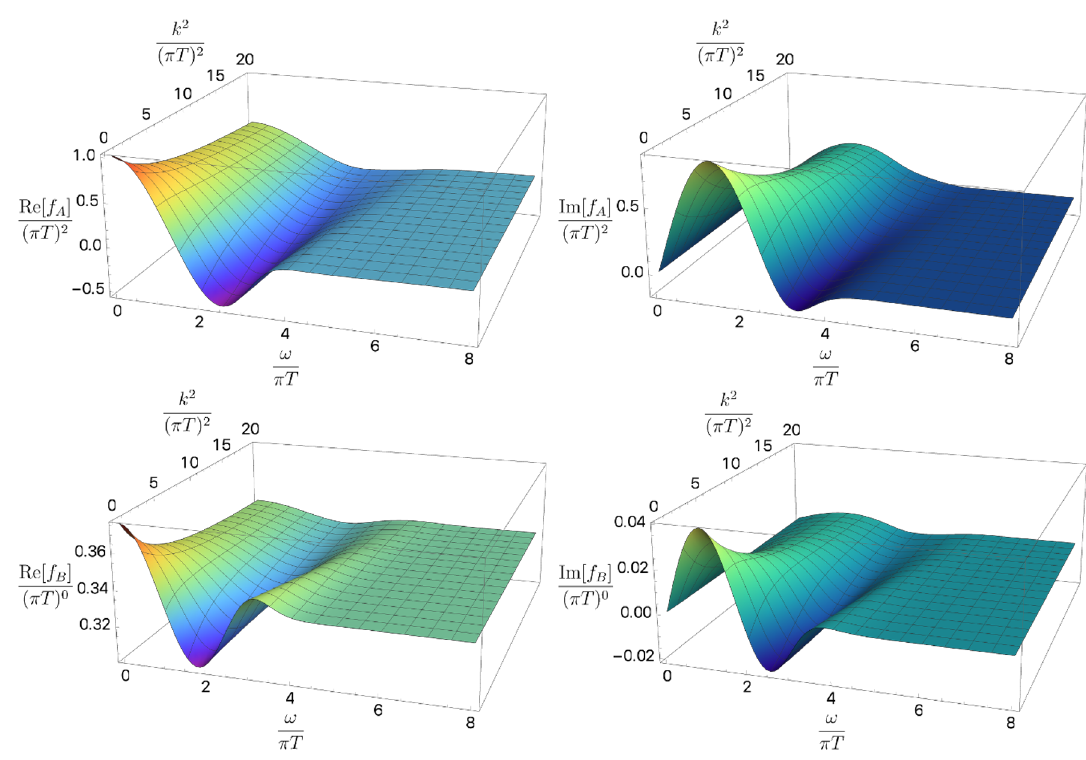
Figure 1 . Real and imaginary parts for the A component (above) and B component (below) of the all order drag force as functions of ! and k 2 . Note that each quantity is displayed in units of (cid:25)T based on their